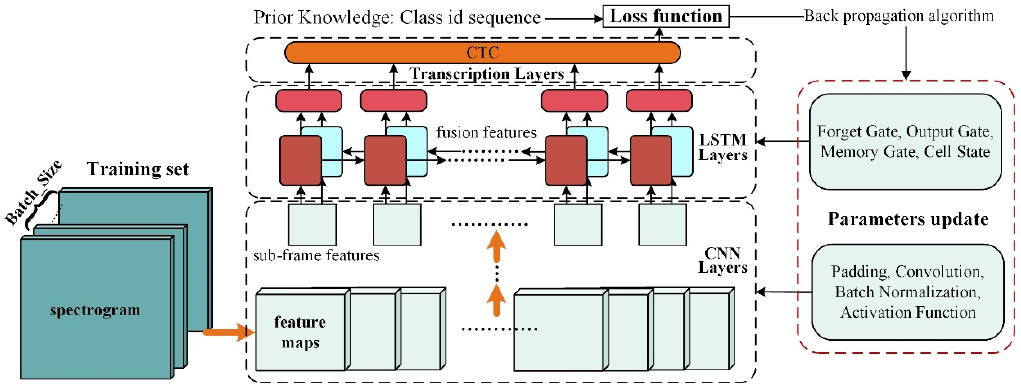
Figure 6. Multi-target sequence detection meta-architecture training process.